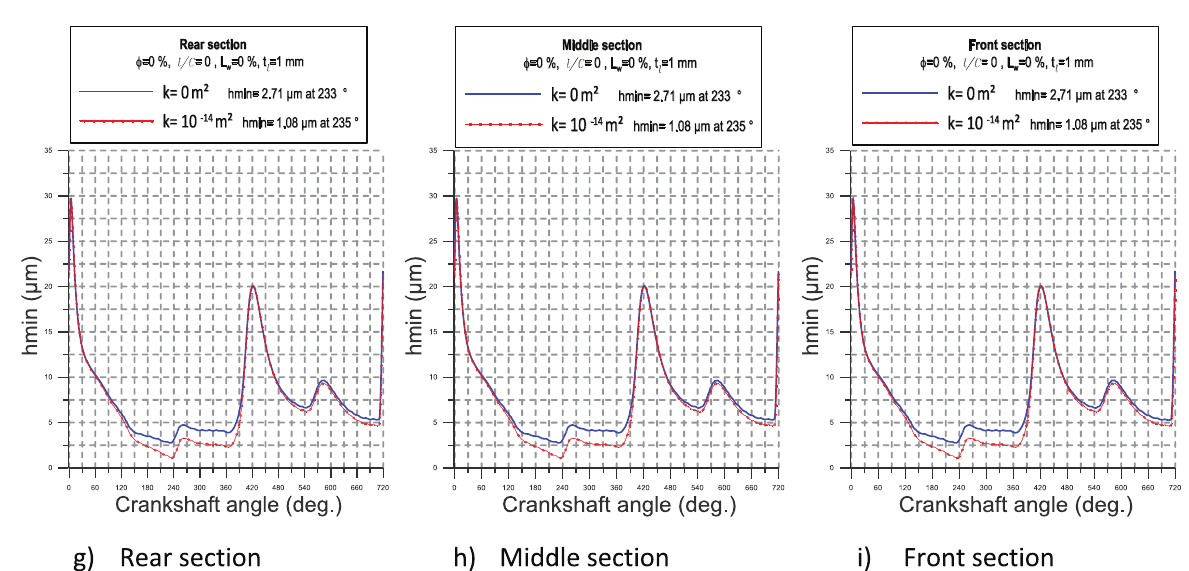
Fig. 24. Effects of bearing-liner permeability parameter on the minimum fi lm thickness over an engine